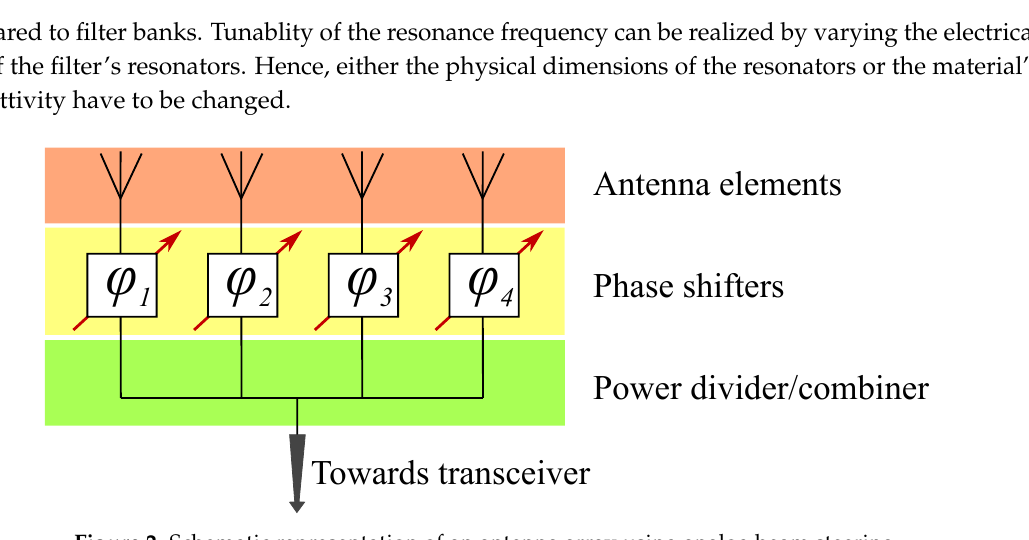
Figure 2. Schematic representation of an antenna array using analog beam steering.